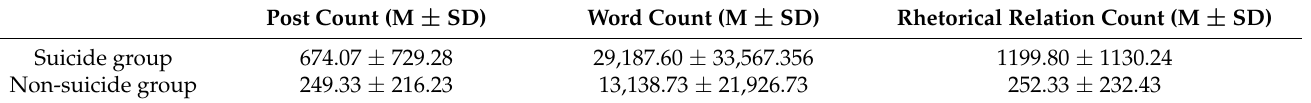
Table 2. The numbers of posts, words, and rhetorical relations of participants by suicidal